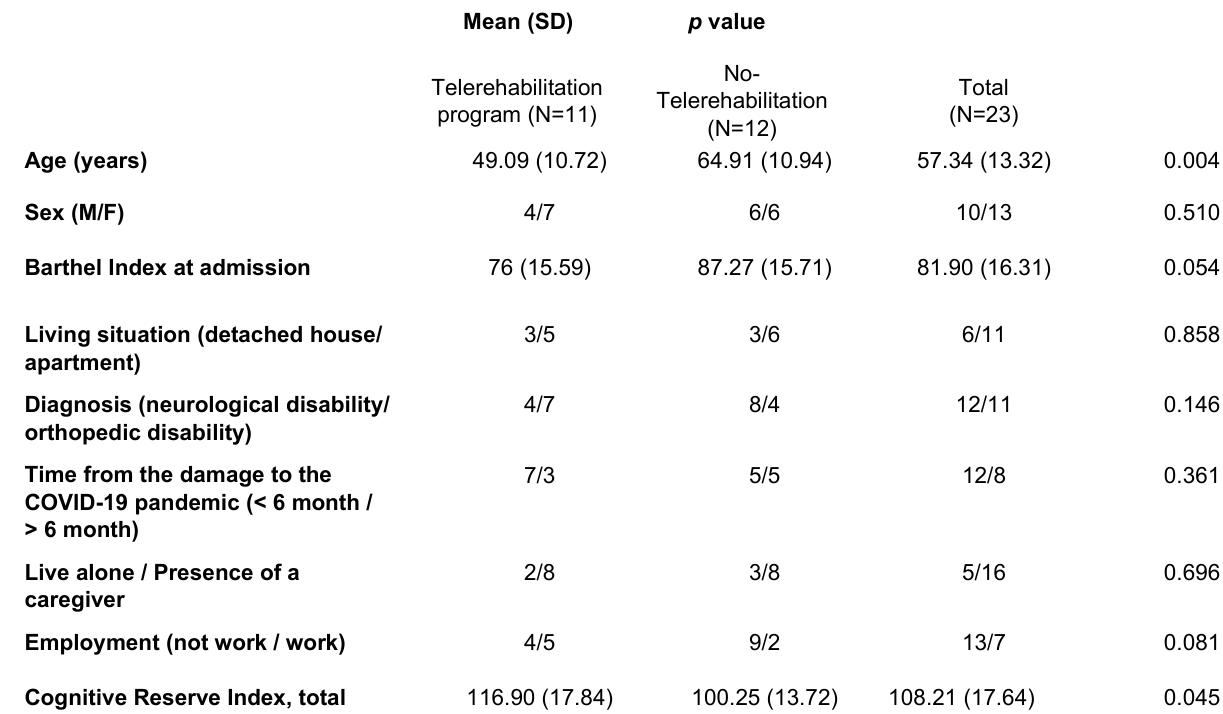
Clinical and Demographic Characteristics of the Participant